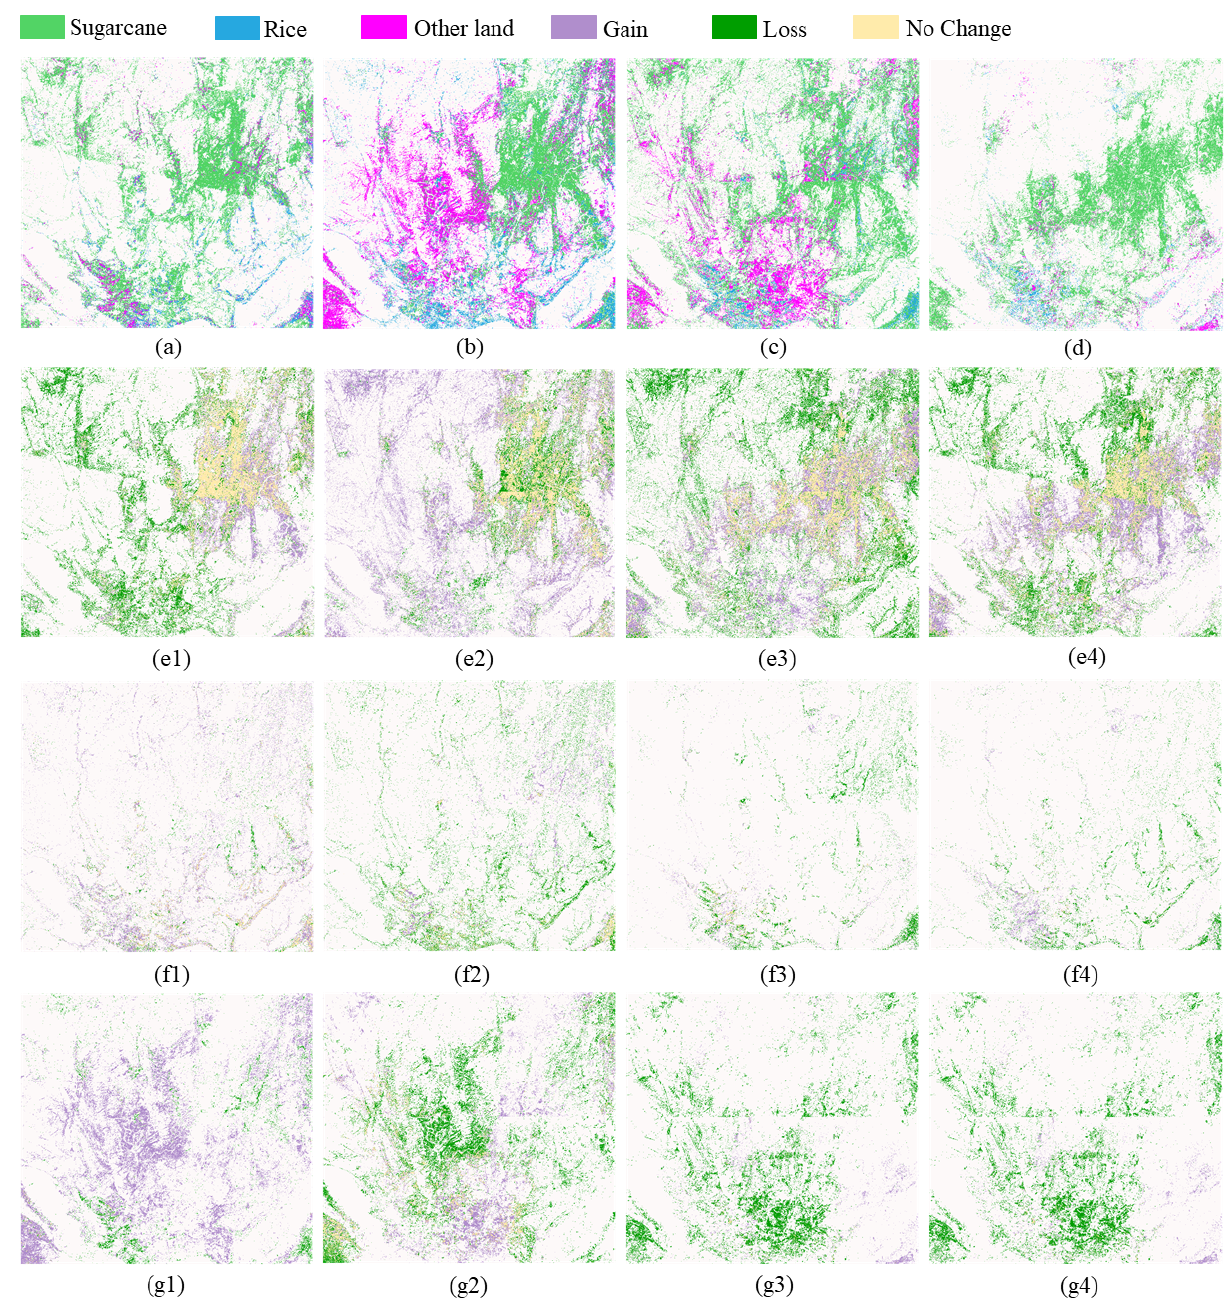
Figure 17. Distribution of crop areas in 2015 ( a ), 2017 ( b ), 2019 ( c ), and 2021 ( d ); dynamics of